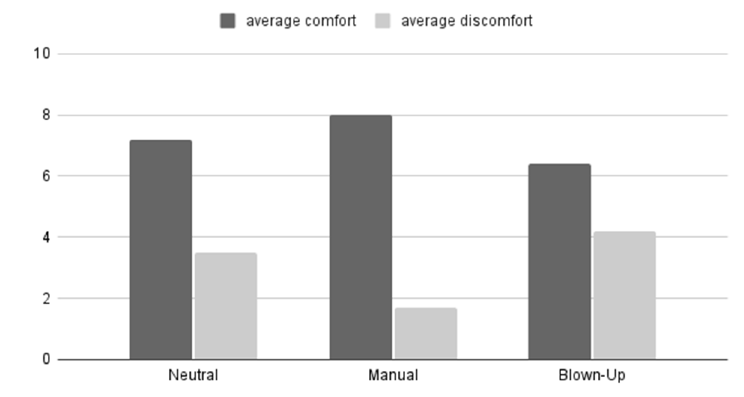
Figure 9. Mean (dis)comfort rating per module on a scale from 0 to 10.